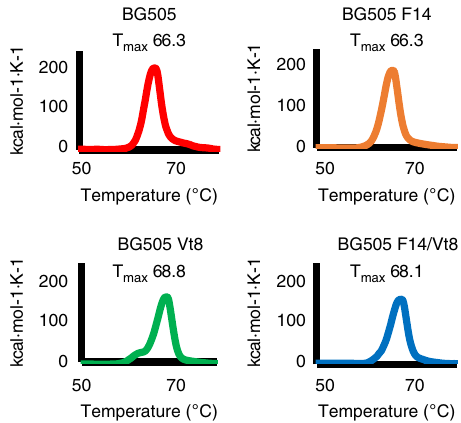
Fig. 2 Physical stability of BG505 SOSIP.664 and mutants. Differential scanning calorimetry data for BG505 parent, F14, Vt8, and F14/Vt8 SOSIPs. Data presented are representative of two independent